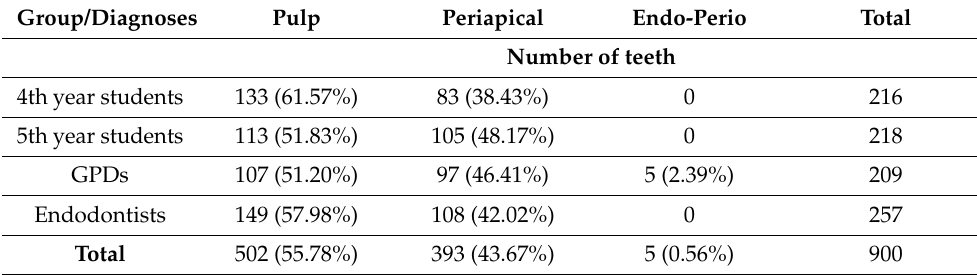
Table 5. The distribution of diagnoses in each